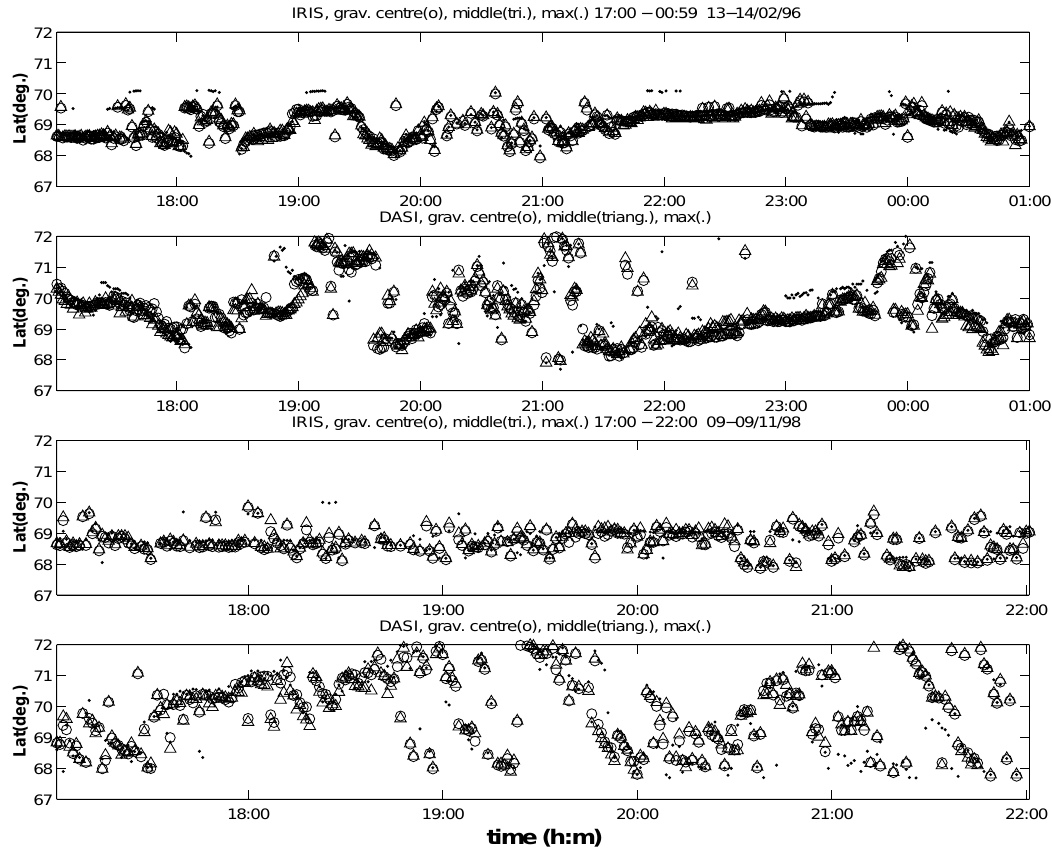
Fig. 10. Latitude of the gravity centre (circles), of the middle point on the major axis (triangles), and of the point of maximum intensity (dots) for the closed contours of maximum length at any given time for both IRIS and DASI observations, in their respective fields of view. The first and second panels from the top are for the 13–14 February 1996 period, whereas the third and fourth are for the 9 November 1998